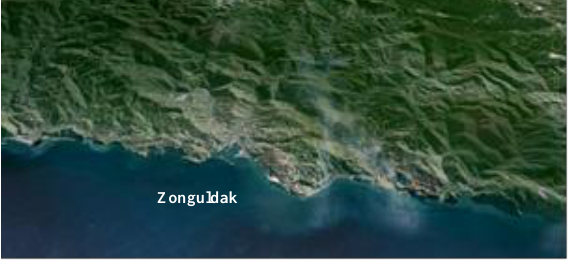
Figure 1. Zonguldak city centre and its inland